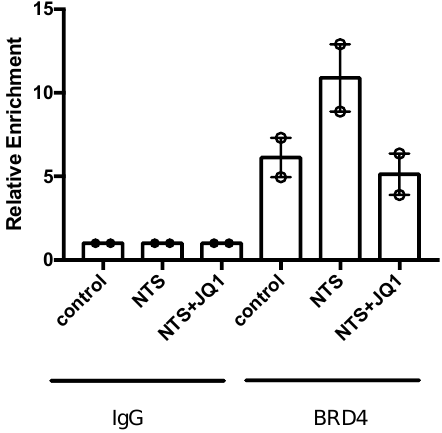
Figure 3. Type IV Collagen is a direct target of iBETs. ChIP assays were performed in renal samples using an antibody specific for BRD4 or normal rabbit IgG as a negative control. Enrichment of BRD4- binding regions in the promoter of mouse Col4a3 was quantified by qPCR using specific primers. In each group, samples were pooled (4–7 mice per group). Data are from two independent experiments, and each qPCR was run in triplicate. Results are expressed as the n-fold enrichment of anti-BRD4 antibody relative to the negative control antibody (considered to be 1).